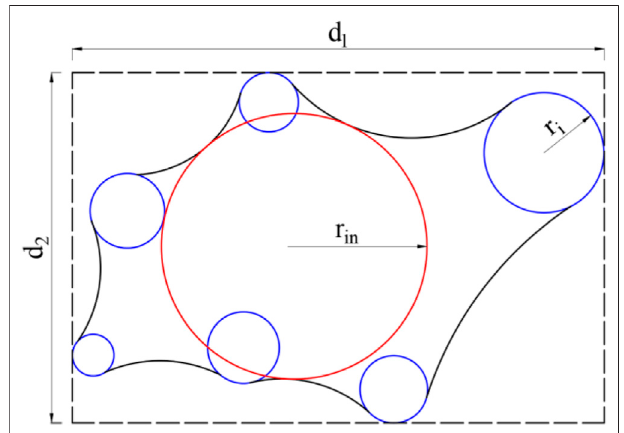
FIGURE 4 | Geometric features of sand